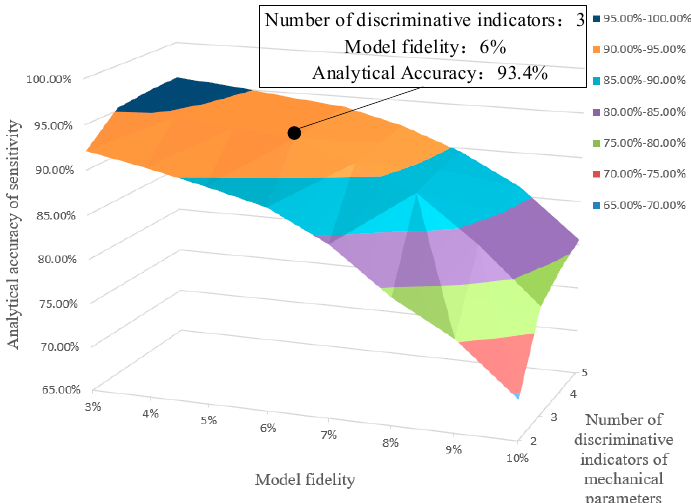
Figure 8. Relationship between the accuracy of sensitive analysis and the fidelity of the model and the number of discriminative indicators.